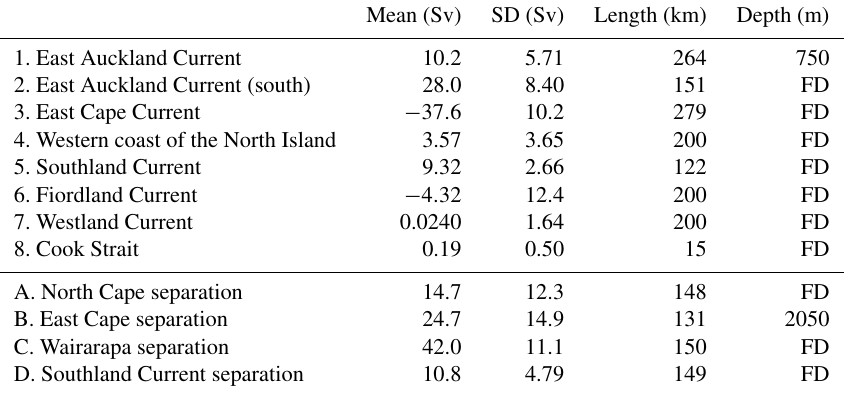
Table 5. Alongshore transport (Sv) through cross-shore sections (Fig. 10, sections 1–8) and the offshore sections (Fig. 10, sections A–D) computed daily for the 25-year hindcast. The section length (which corresponds to the distance offshore for sections 1–7) and depth over which the transport is computed is defined by the + 0 . 05 or − 0 . 05ms − 1 contour in the velocity mean (the sign depending on the mean flow direction), expect in cases where there is no defined core, in which case a distance of 200km offshore is chosen. Section length and depth are included in the table. FD: full